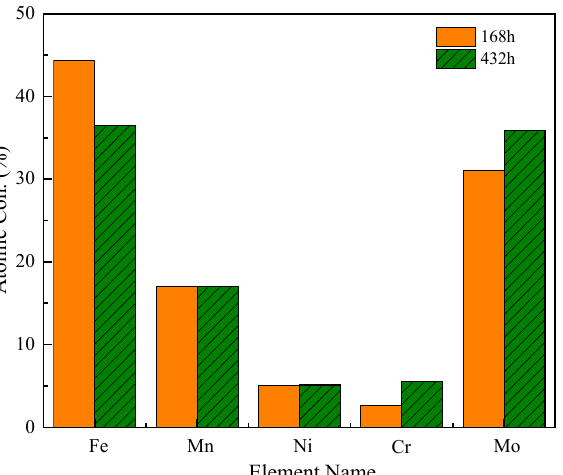
Figure 9. Atomic concentration of main elements in corrosion products after 168 h and 432 h corrosion.